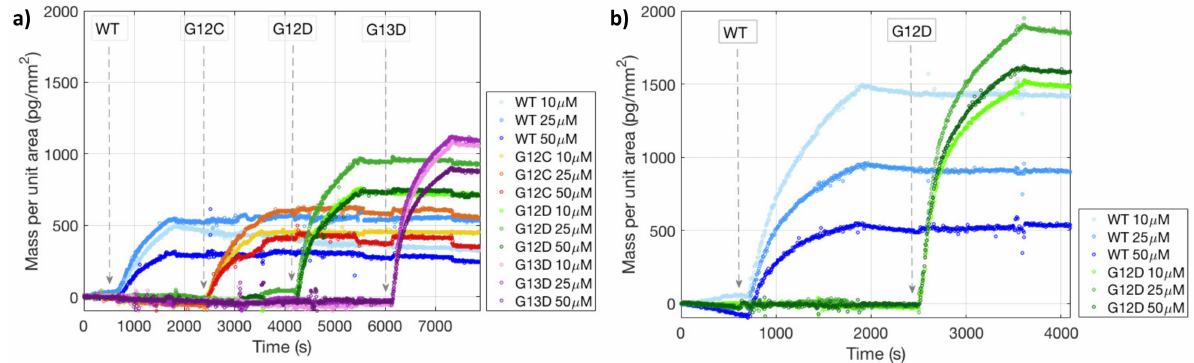
Figure 8. Binding curves obtained with the IRIS system for complementary targets binding to the respective probes at different concentration on a ( a ) MCP-4 ( b ) Copoly Azide 10% coated